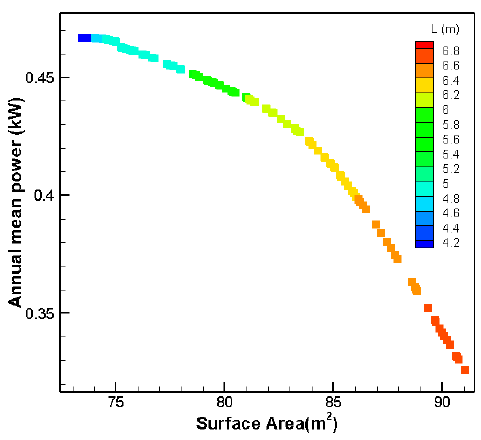
Figure 10. Optimization results of the parallelepipedic hull shape for length parameter.